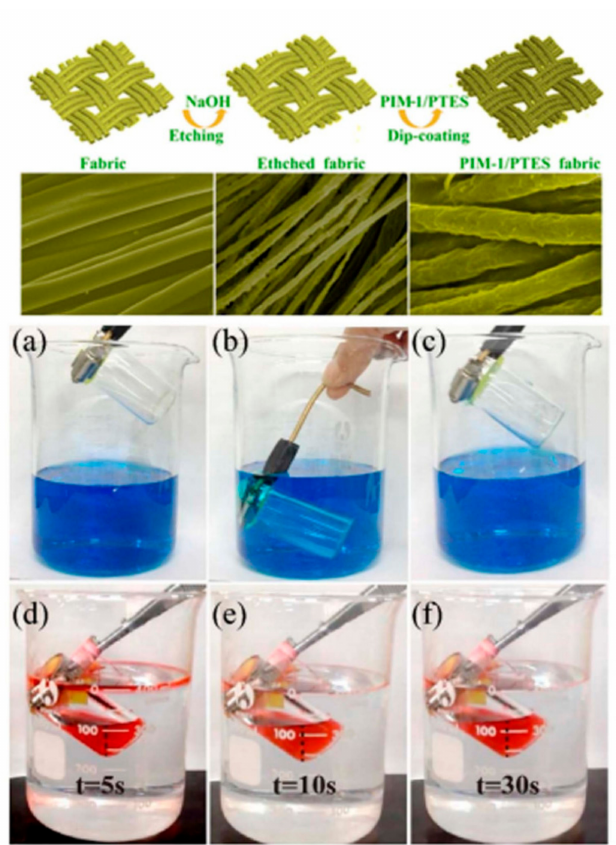
Figure 10. ( Top ) Schematic illustration of the superhydrophobic fabrics fabricated by etching and dip-coating process. ( Bottom ) Images showing oil–water separation and collection by a superhydrophobic fabric-equipped device. Images showing ( a – c ) no water collection and ( d – f ) hexadecane oil collection. Reproduced with permission from [202]. Copyright 2019 American Chemical